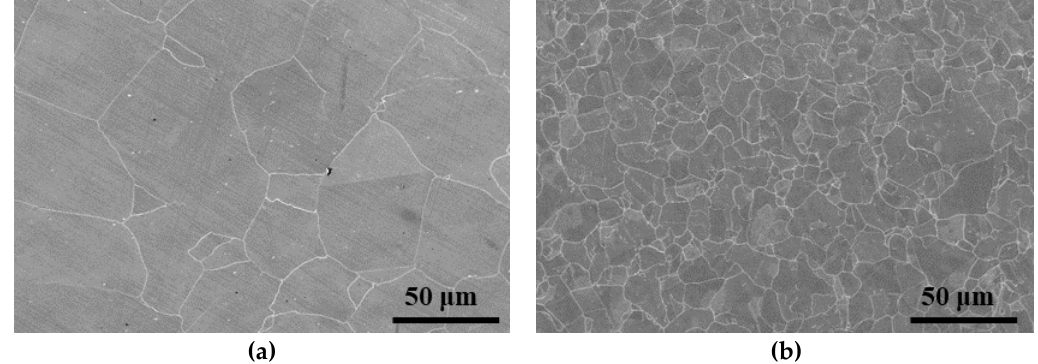
Figure 2. Microstructures of TP347H and TP347HFG. ( a ) TP347H; ( b ) TP347HFG. Table 1. Compositions of steels TP347H and TP347HFG (wt.%).